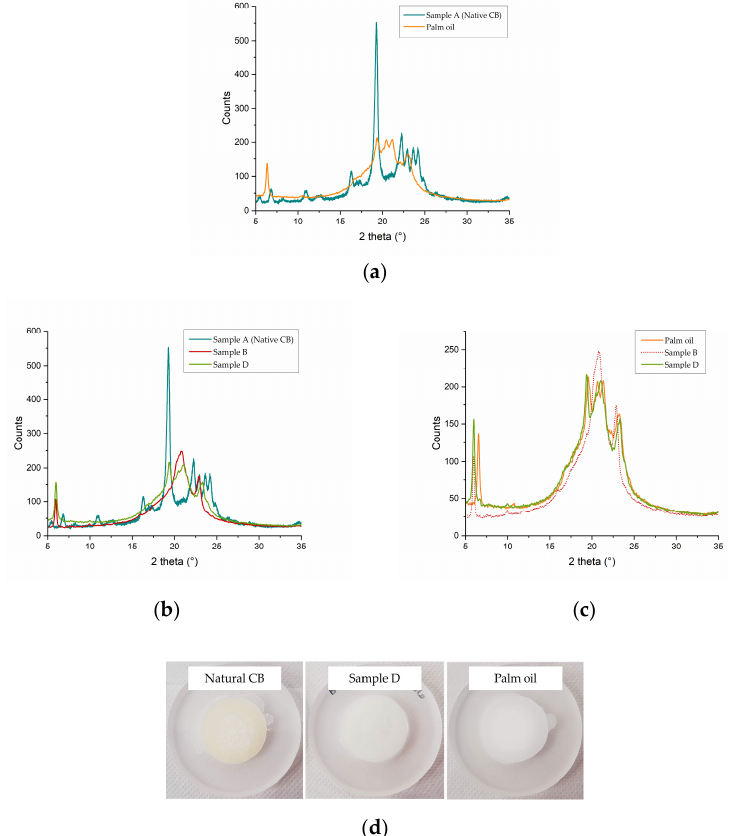
Figure 5. Comparison of PXRD patterns for ( a ) native CB (in blue), and PO (in orange); ( b ) native CB (in blue), sample B (in red), and sample D (in green); ( c ) PO (in orange), sample B (in red, dotted line) and sample D (in green). Figures show that the more heavily modified the fat, with SUS-type TAGs converted into SSU-type, the closer the X-ray profile is to that of PO. ( d ) A view of the native CB, modified sample D, and PO after the three cycles of heating/cooling and storage at 4 °C for 72 h before the PXRD measurements.